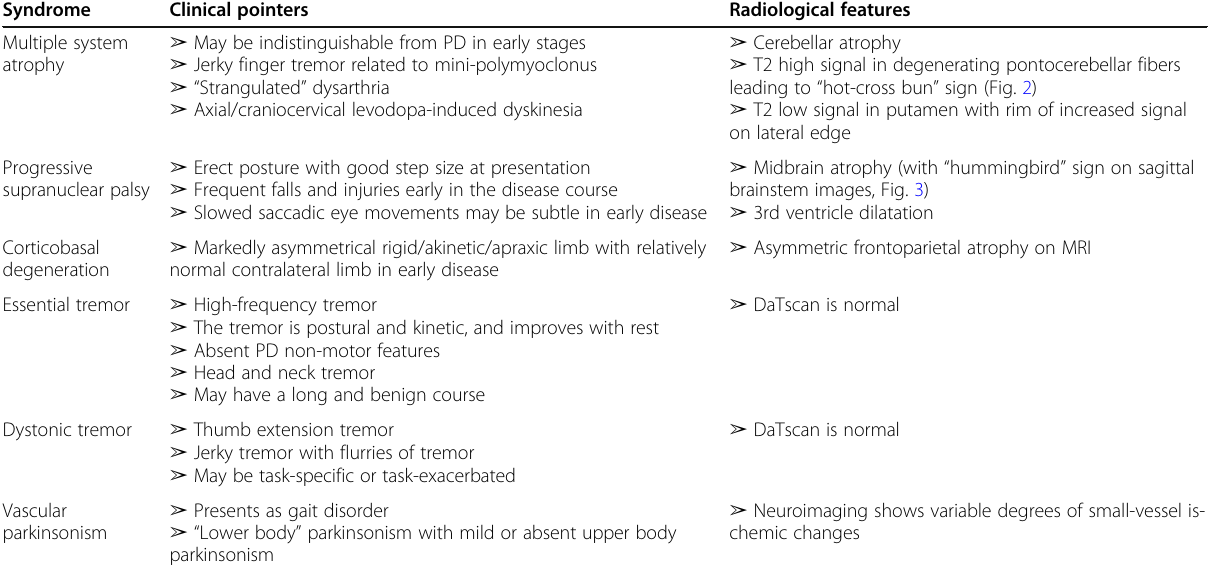
Table 1 Clinical pointers and radiological features in parkinsonian syndromes by various imaging techniques [55] Syndrome Clinical